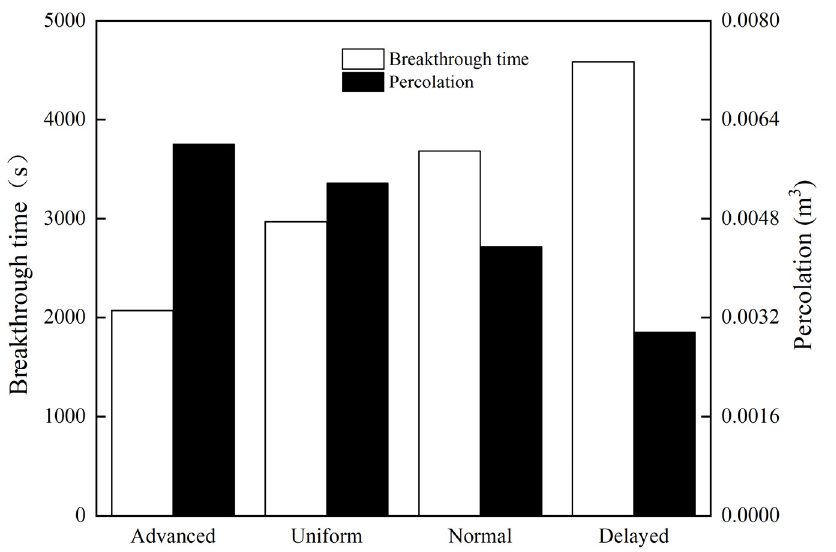
Figure 9. Breakthrough time and percolation in four rainfall patterns under relatively short rainfall